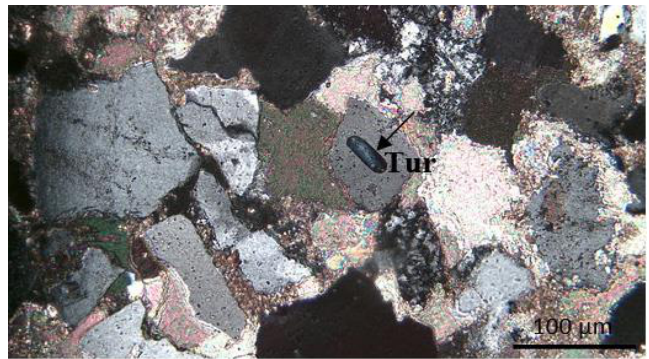
Figure 13. Tourmaline (Tur): crossed polars, 100× magnification.